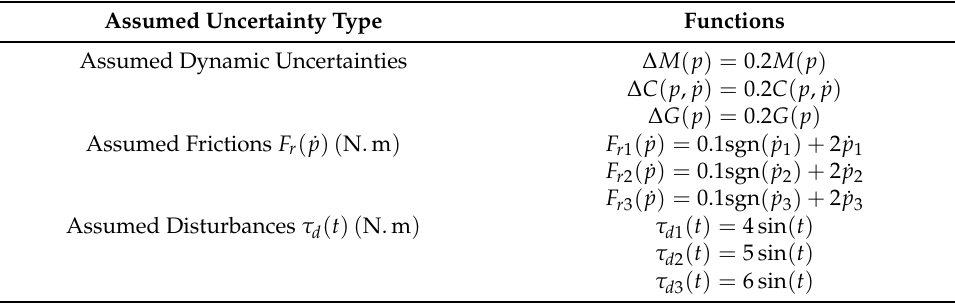
Table 2. Assumed uncertain terms in simulation process.